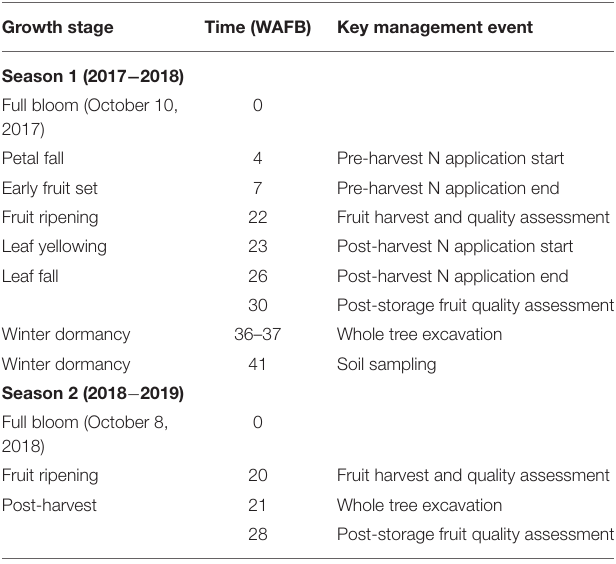
TABLE 1 | Key management events and the respective growth stages over the 2017–2018 and 2018–2019 growing seasons, related to weeks after full bloom